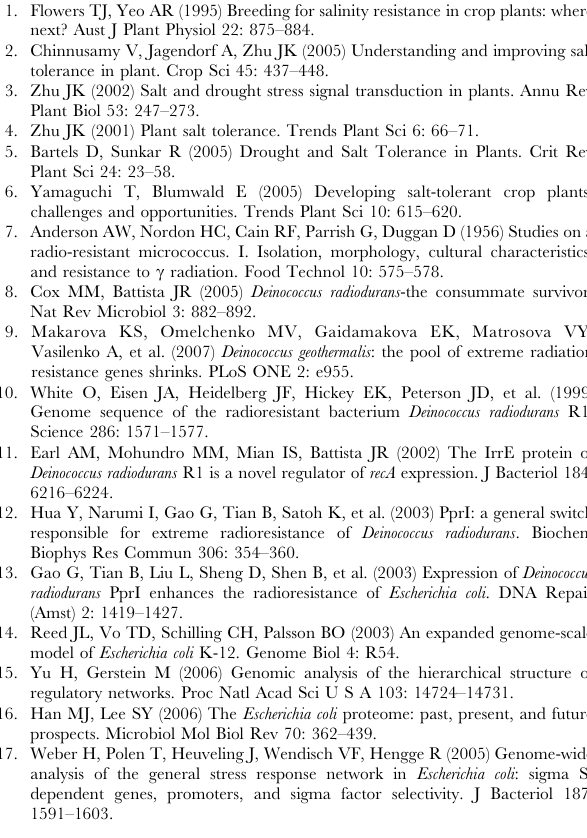
Table S1 Upregulated proteins of the E. coli strain expressing IrrE versus the control strain carrying only the pMG1vector in